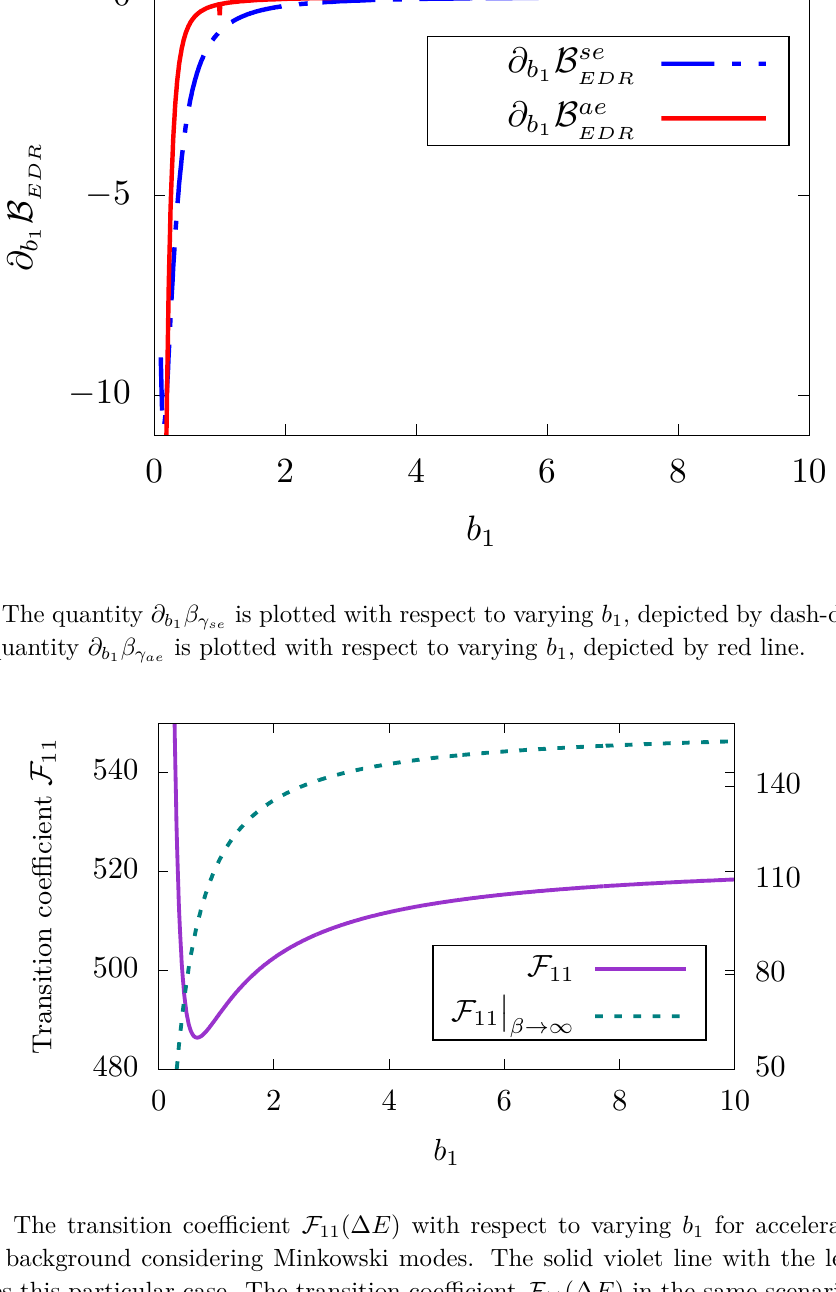
Figure 8 . The transition coefficient F 11 (∆ E ) with respect to varying b 1 for accelerated atoms in thermal background considering Minkowski modes. The solid violet line with the left vertical axis denotes this particular case. The transition coefficient F 11 (∆ E ) in the same scenario with the temperature of the thermal bath now zero denoted by the dotted green line with right vertical